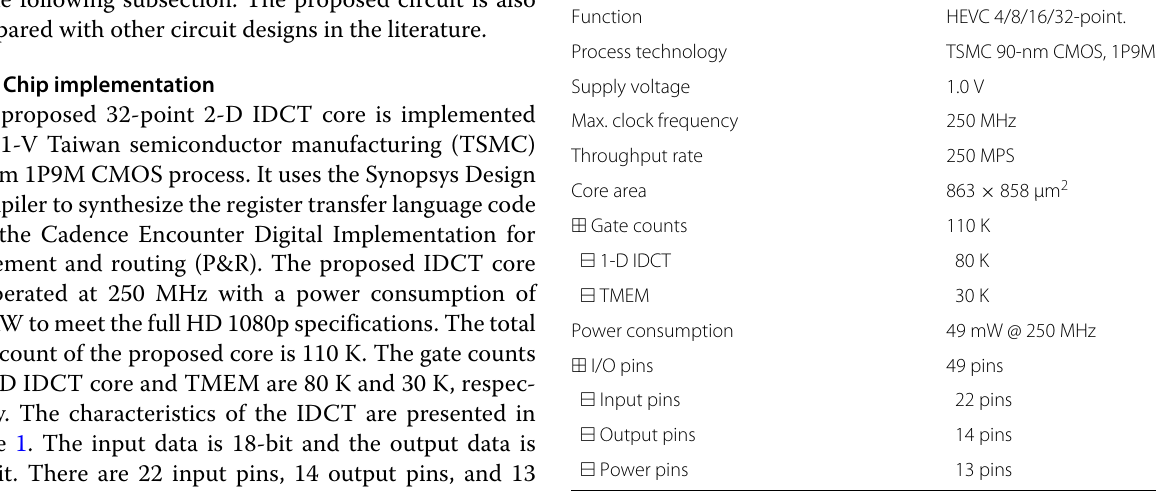
48th cycle, BF16 outputs the first 32-point 1-D trans- form data and inputs the following 32-point transform data. After 1008 cycles, the 2nd-D data is output from the TMEM and fed into the PEE4 module. In these 16